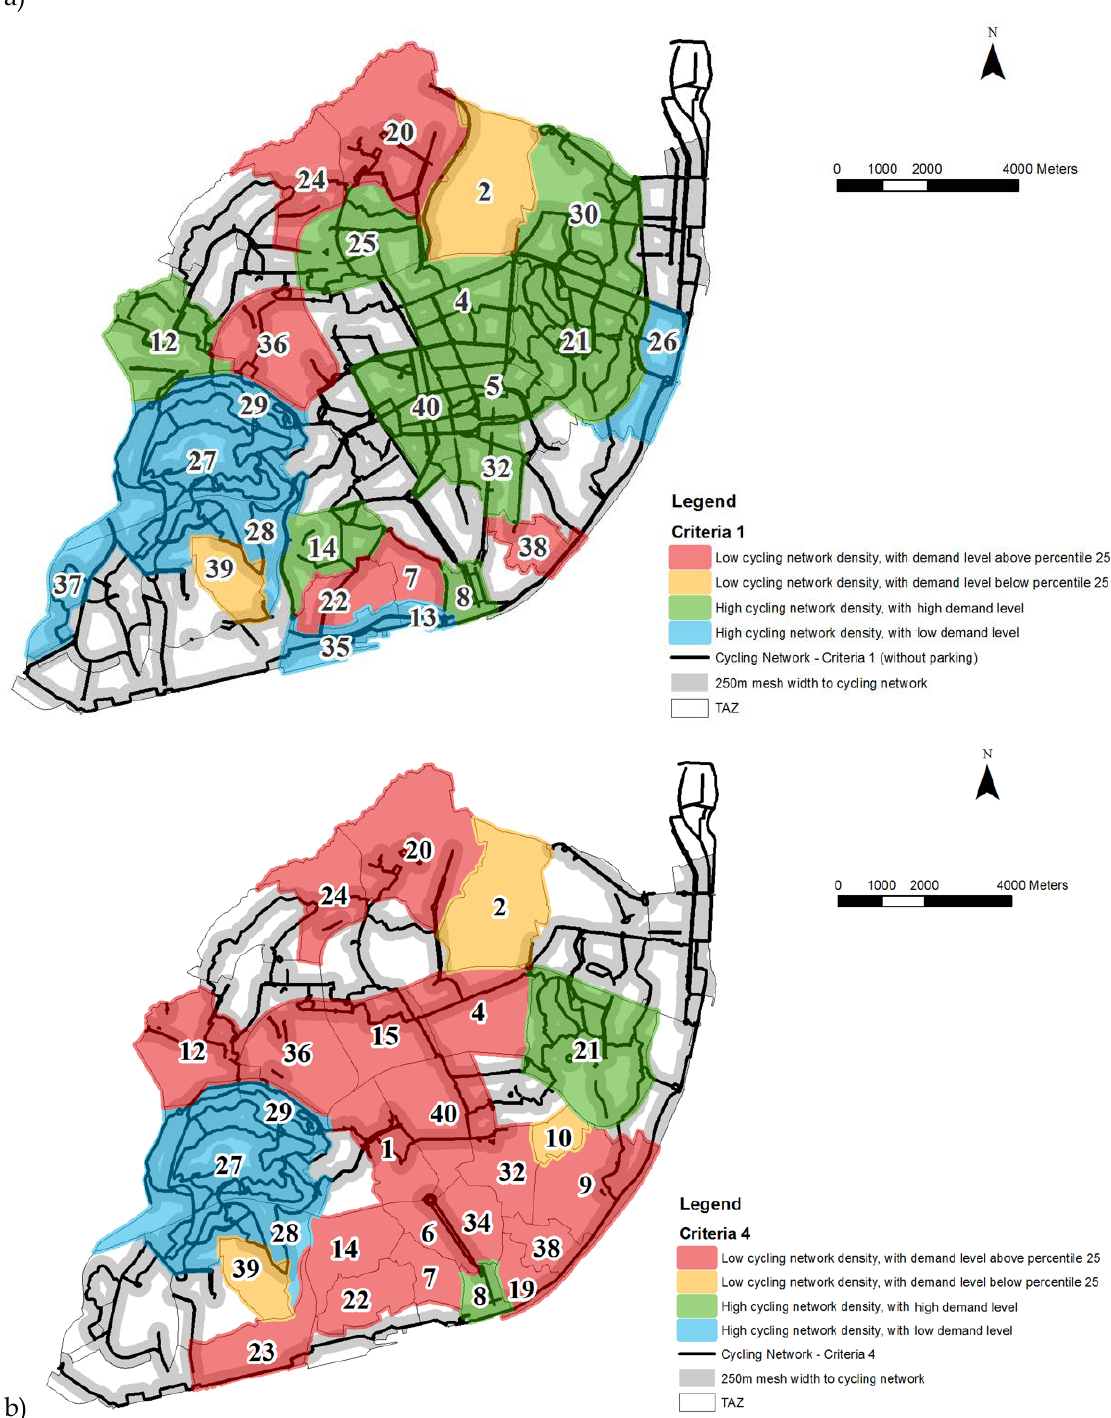
Figure 9. Cycling network coverage for (a) criteria 1 with parking removal and (b) criteria 4 without parking